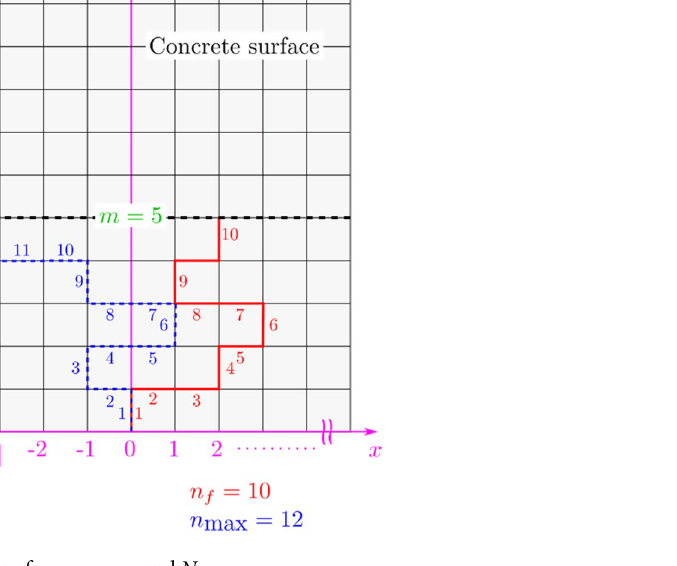
Figure 17. Definitions of m , n f , n max , and N L